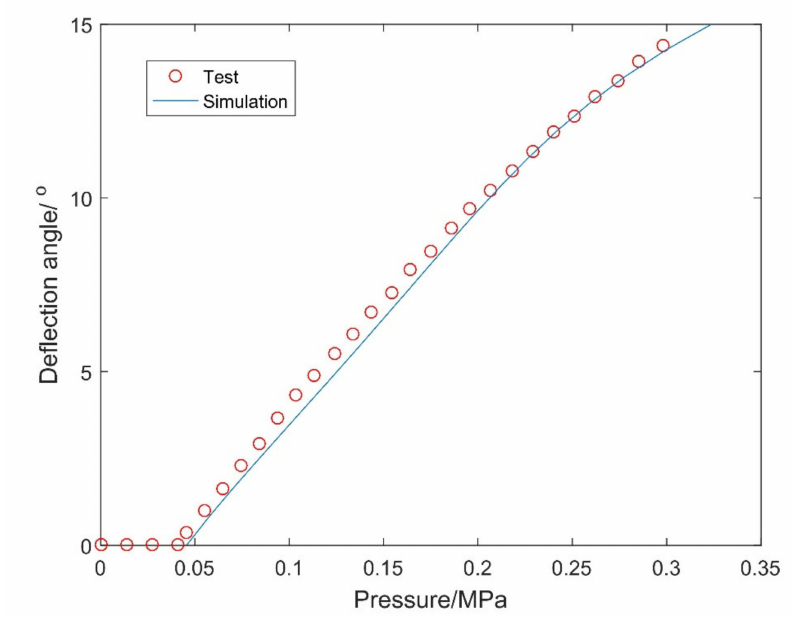
Figure 8. Driving pressure vs. deflection